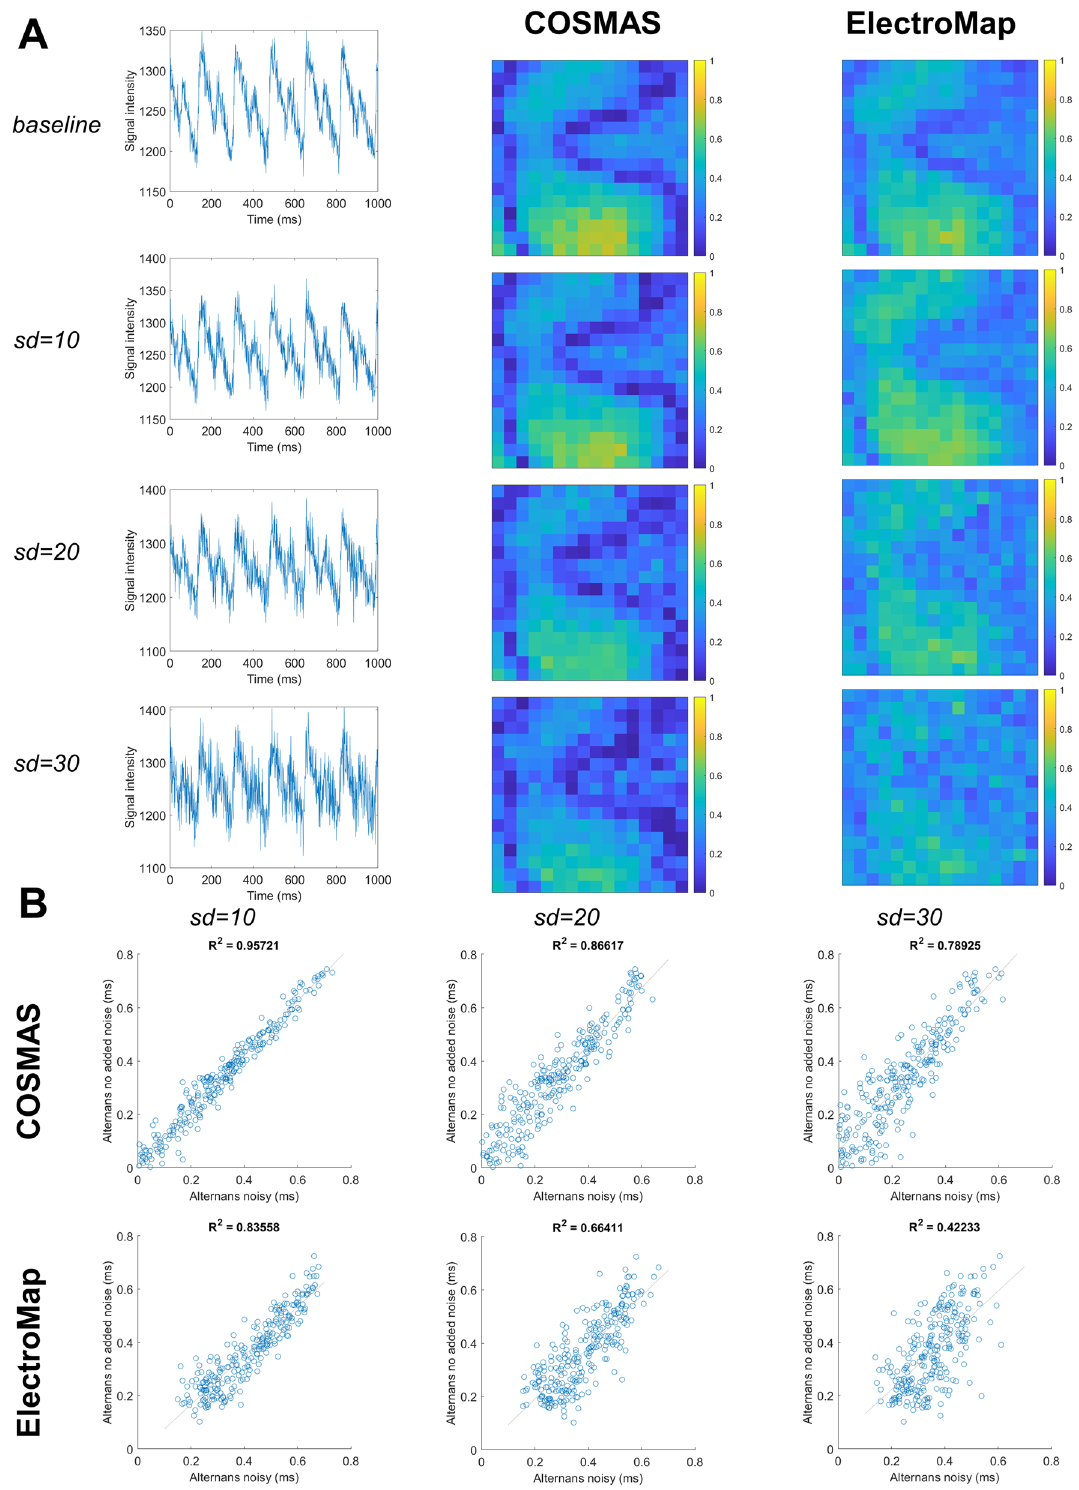
Figure 10. Robustness of COSMAS’ and ElectroMap’s alternans mapping to noise. The structure of the figure is identical to Figure 9. Sample traces in ( A ) come from pixel row = 13, column = 7 in the recording. Given different amplitude of the calcium signal, lower amount of Gaussian noise was applied. Parameters of COSMAS and ElectroMap were matched whenever possible, including the alternans metric (see “Methods” section for details). The original data with no added noise come from Langendorff-perfused rat hearts paced at 85 ms basic cycle